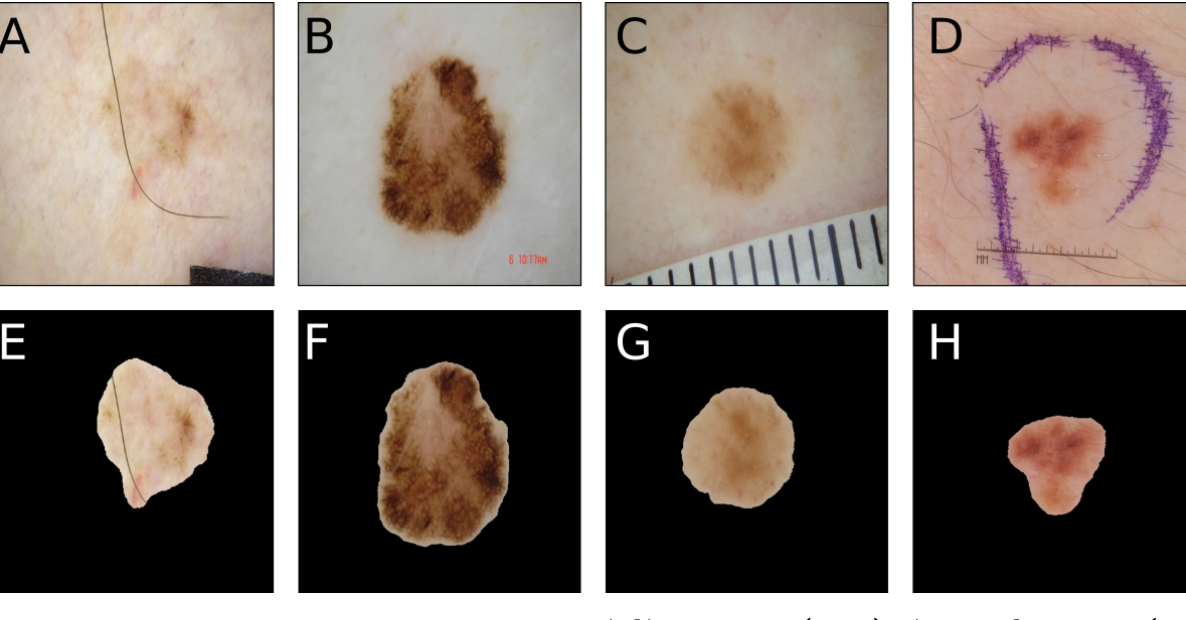
Figure 1. Typical artifacts encountered in dermoscopic image databases. Panels A-D show an exemplary range of artifacts often found in dermoscopic images, which are (left to right) color charts and hair, text, ruler markings, and marker ink. Panels E-H show how a corresponding segmented image could look like, with the surrounding artifacts removed but artifacts within the lesion (Panel E) still